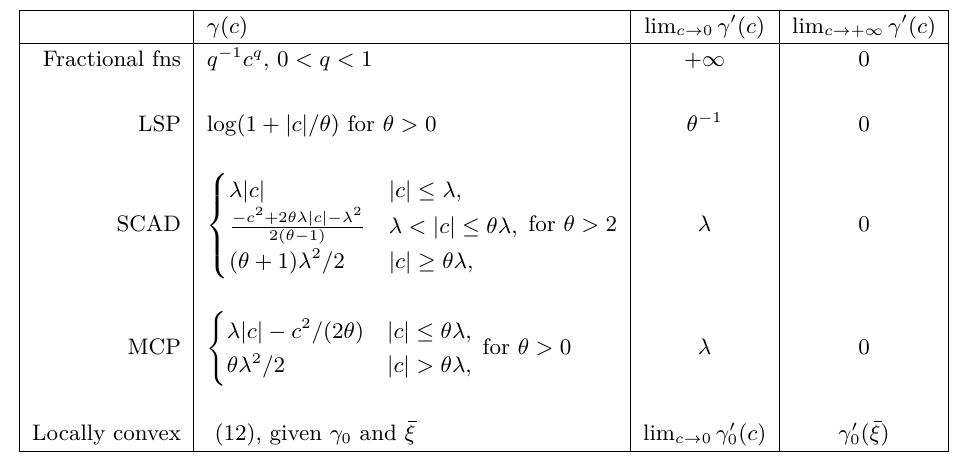
Table 1 A list of several popular concave penalties, and their slope behavior at extremities. The last entry shows the effect of the piecewise construction, which becomes linear with non-zero slope at large values of ξ